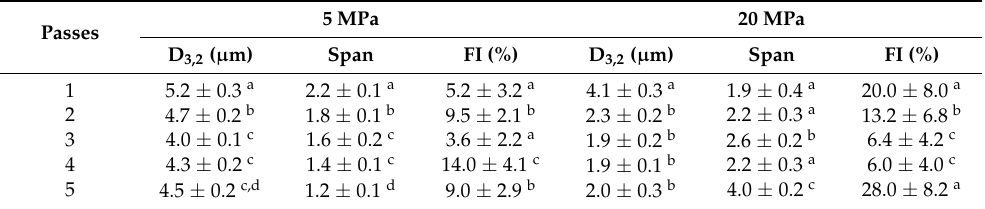
Table 2. Parameters (D 3,2 , Span and FI) from droplet size distribution as a function of the number of emulsion passes through the high-pressure homogenizer and the two pressures studied (5 MPa and 20 MPa). Different superscript letters within a column indicate significant differences ( p < 0.05).